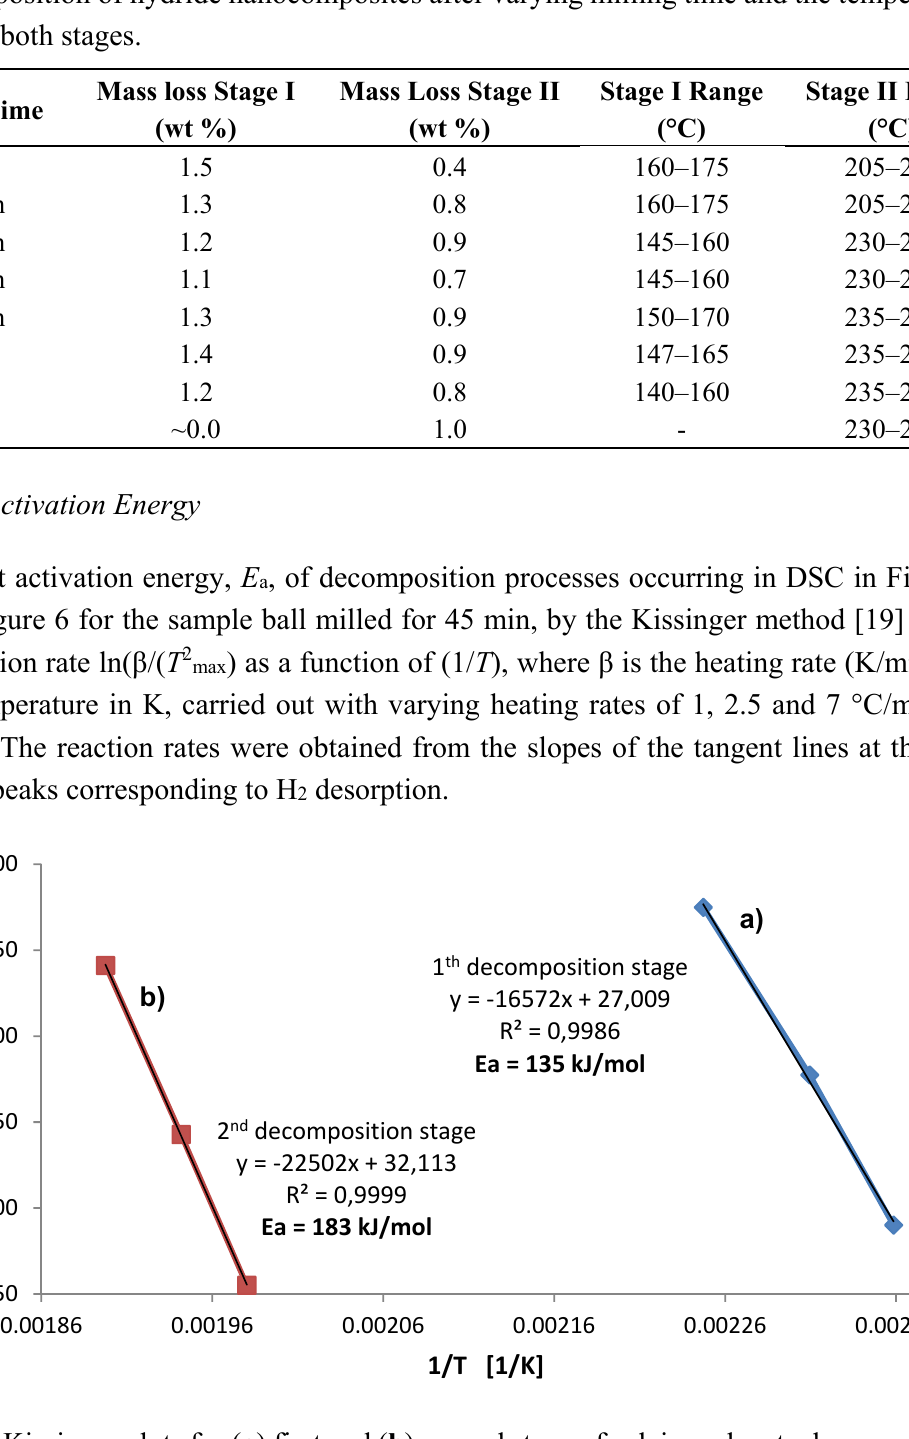
Figure 6. Kissinger plots for ( a ) first and ( b ) second stage of calcium alanate decomposition for the sample milled for 45 min (Figure